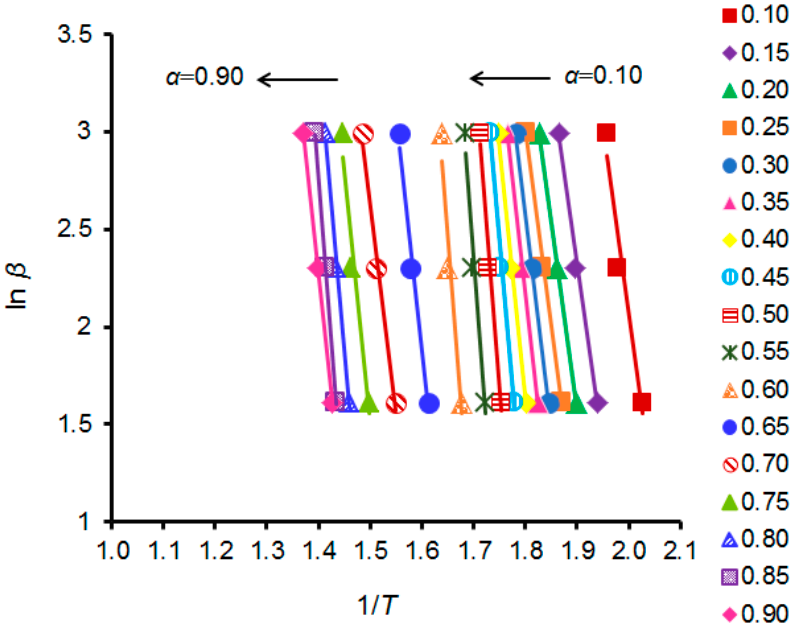
Figure 3. Isoconversion lines obtained by OFW method.